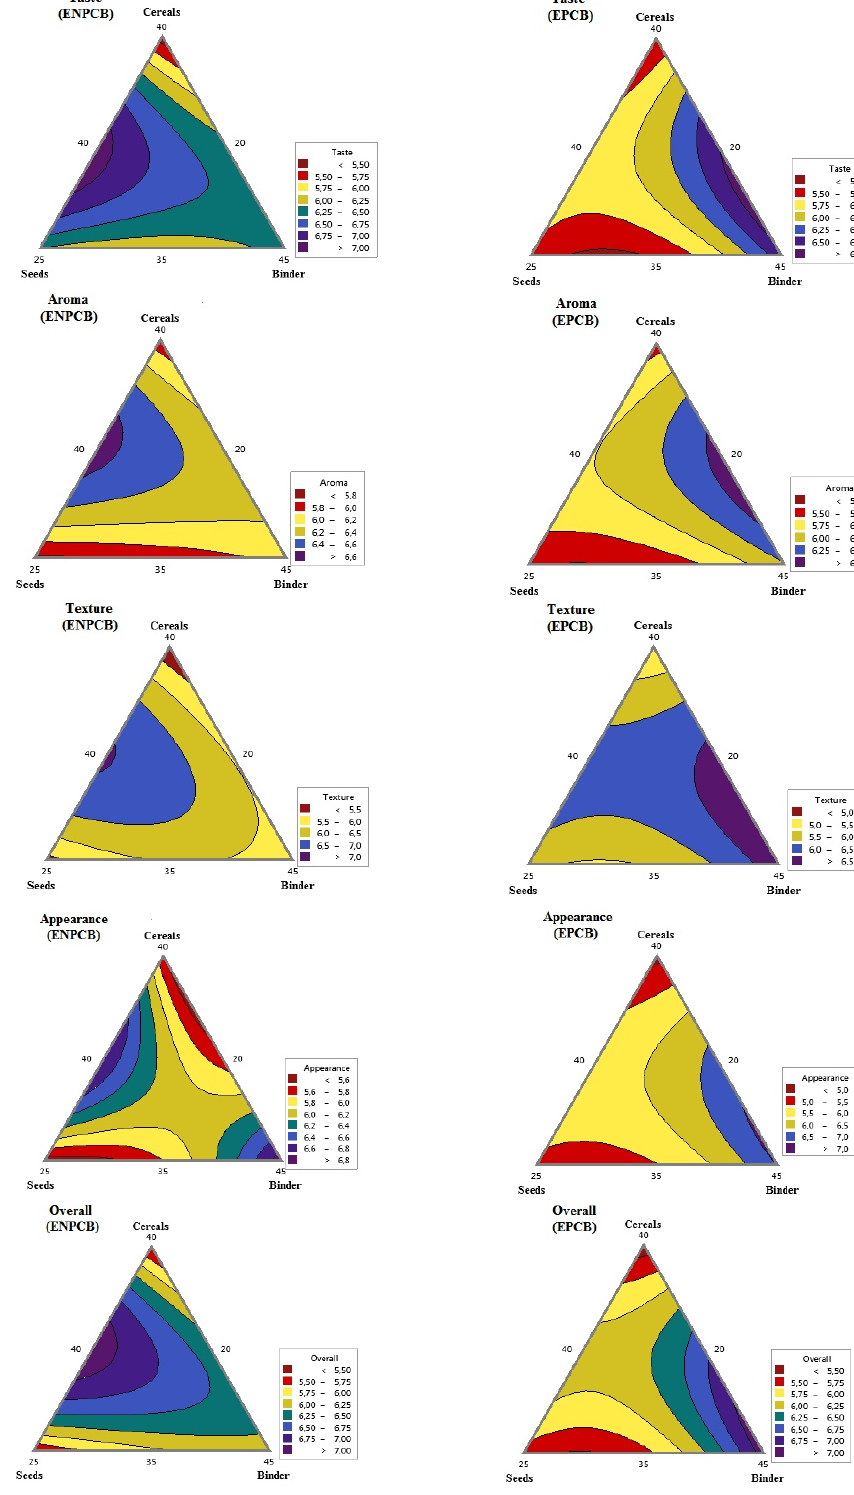
Figure 1. Contour plots for predicted sensorial attributes for gluten-free energy-rich cereal bars.